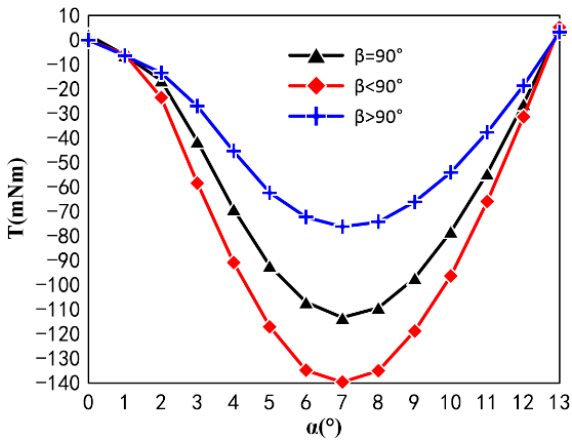
Figure 12. Cogging torque waveforms of CPT with different shapes.